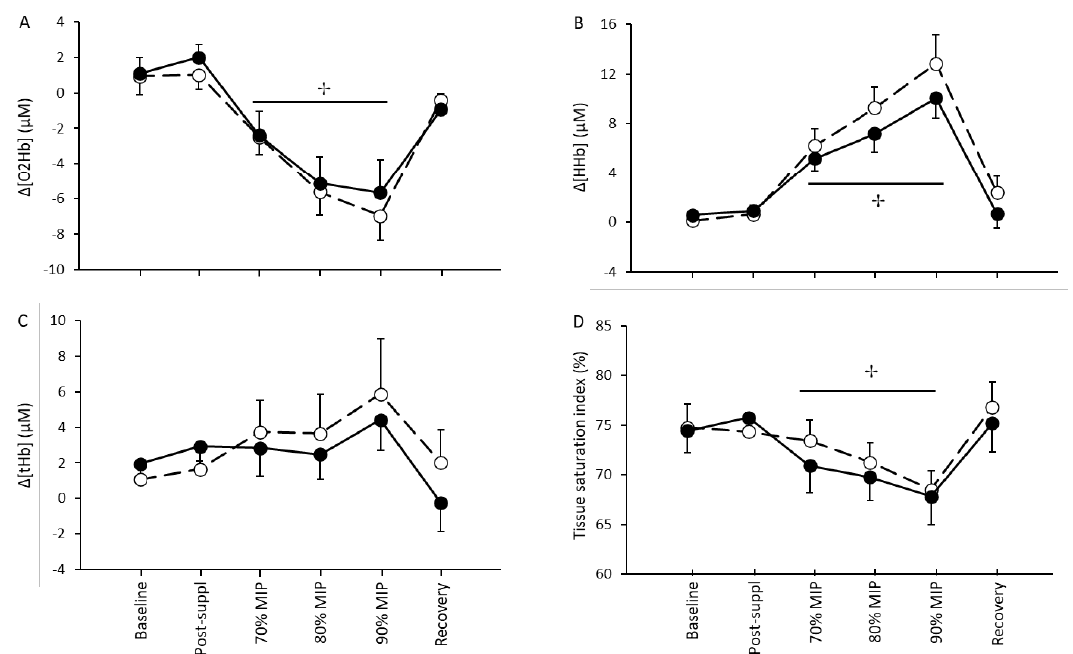
Figure 4. Sternocleidomastoid muscle oxyhemoglobin (O 2 Hb) ( A ), deoxyhemoglobin (HHb) ( B ), total hemoglobin (tHb) ( C ), and tissue saturation index at baseline, one hour after the L-citrulline (closed circles) and placebo (open circles) supplementation and after resistive breathing to task failure. ( ✢ ) indicates significant main effect of time ( p < 0.05).